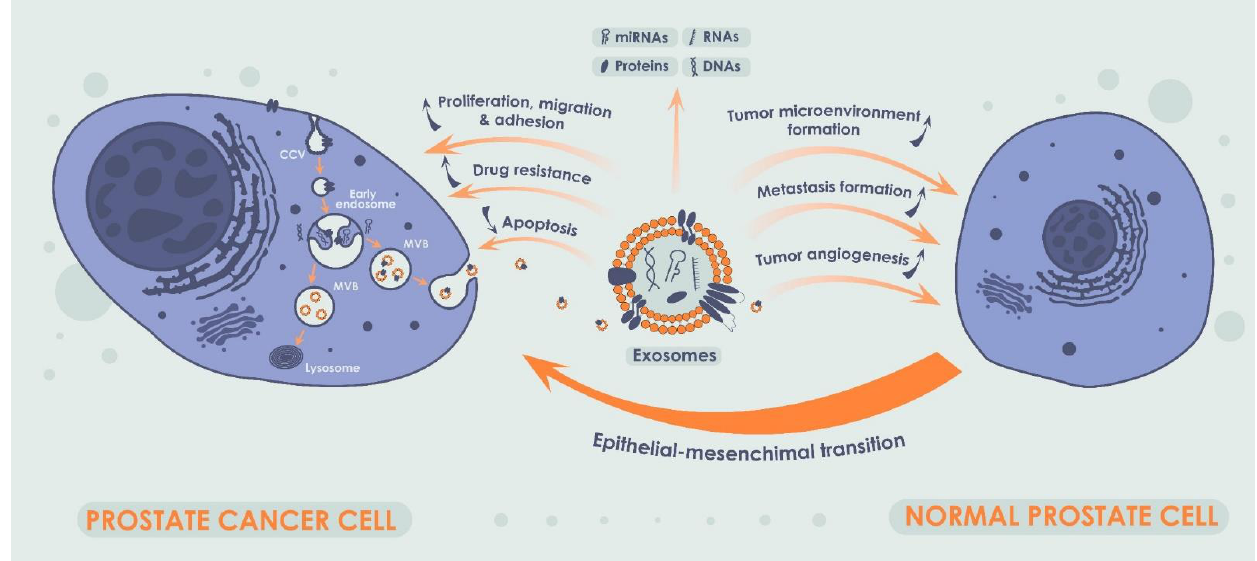
Figure 3. Production of exosomes in cancer cells and their impact on normal prostate cells. A single exosome is formed due to the invagination of the early endosome into the cellular membrane. Exosomes can carry not only miRNAs but also other nucleic acids, a broad spectrum of proteins and lipids, and their combinations thereof. Exosomes, acting as intercellular messengers, are capable of influencing tumor progression by stimulating the proliferation and migration of cancer cells, enhancing cell adhesion, and inhibiting apoptosis. Additionally, exosomes play a crucial role in formation of drug resistance. In addition, exosomes and exosomal miRNA may influence tumor progression by modulating tumor microenvironment, metastasis, and tumor angiogenesis. Notably, exosomal miRNAs in PCa plays a critical role in epithelial – mesenchymal transition.